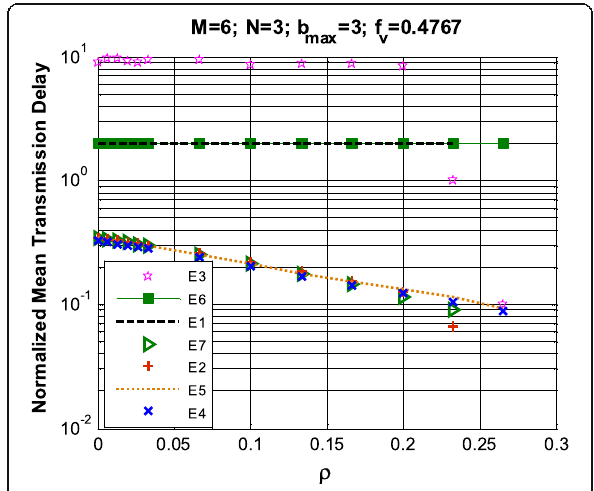
Fig. 7 Normalized mean transmission delay as a function of ρ , for f v = 0.4767